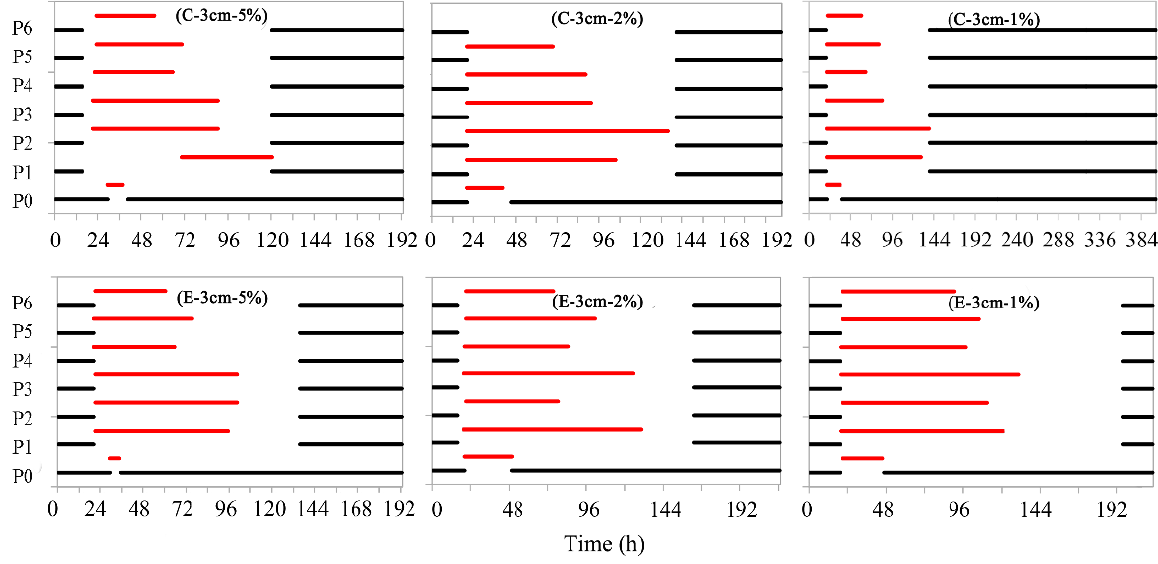
Figure 11. Scheduling schemes under different frequency rainfall conditions in the current and extreme climate scenario (initial storage depth of 0 cm).